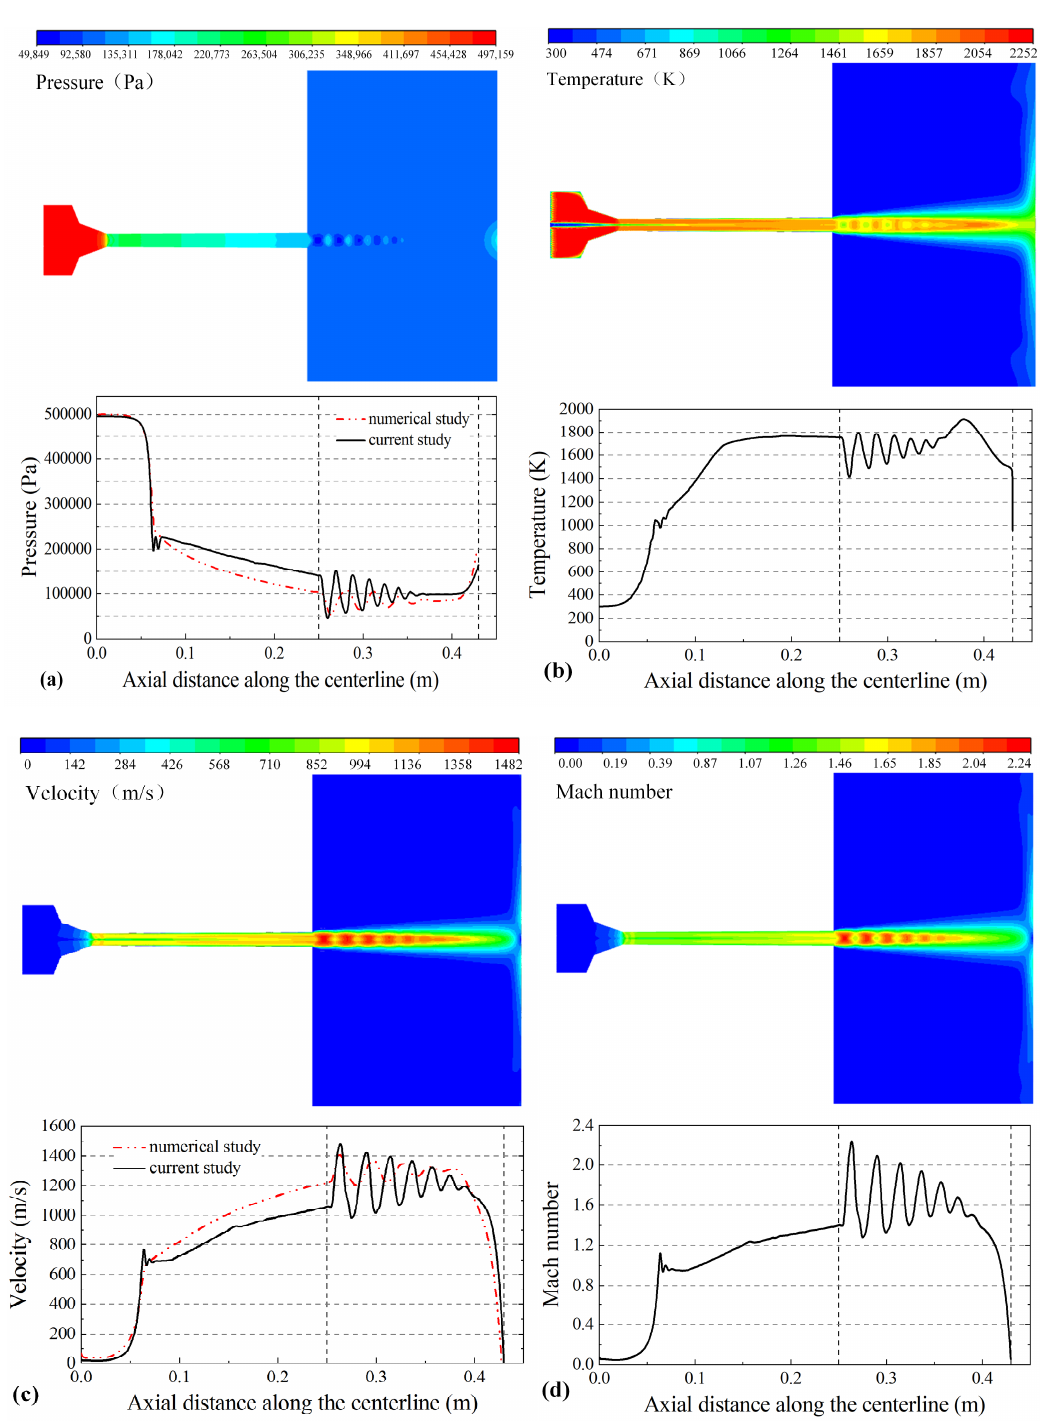
Figure 3. The contours of the flame (top) and flame flow characteristics along the centerline (bottom): ( a ) gas pressure (Pa), ( b ) gas temperature (K), ( c ) gas velocity (m/s) and ( d ) Mach number. The distribution curves of each component for the combustion reaction during spray- ing along the centerline are shown in Figure 4. In the combustion chamber, nitrogen is the main gas component on the centerline, and a large amount of the fuel and combustion aid are not observed due to the inlets that are not on the centerline. Due to the turbulent mix- ing of gas, the mass fraction of the nitrogen gradually decreases and the concentration of